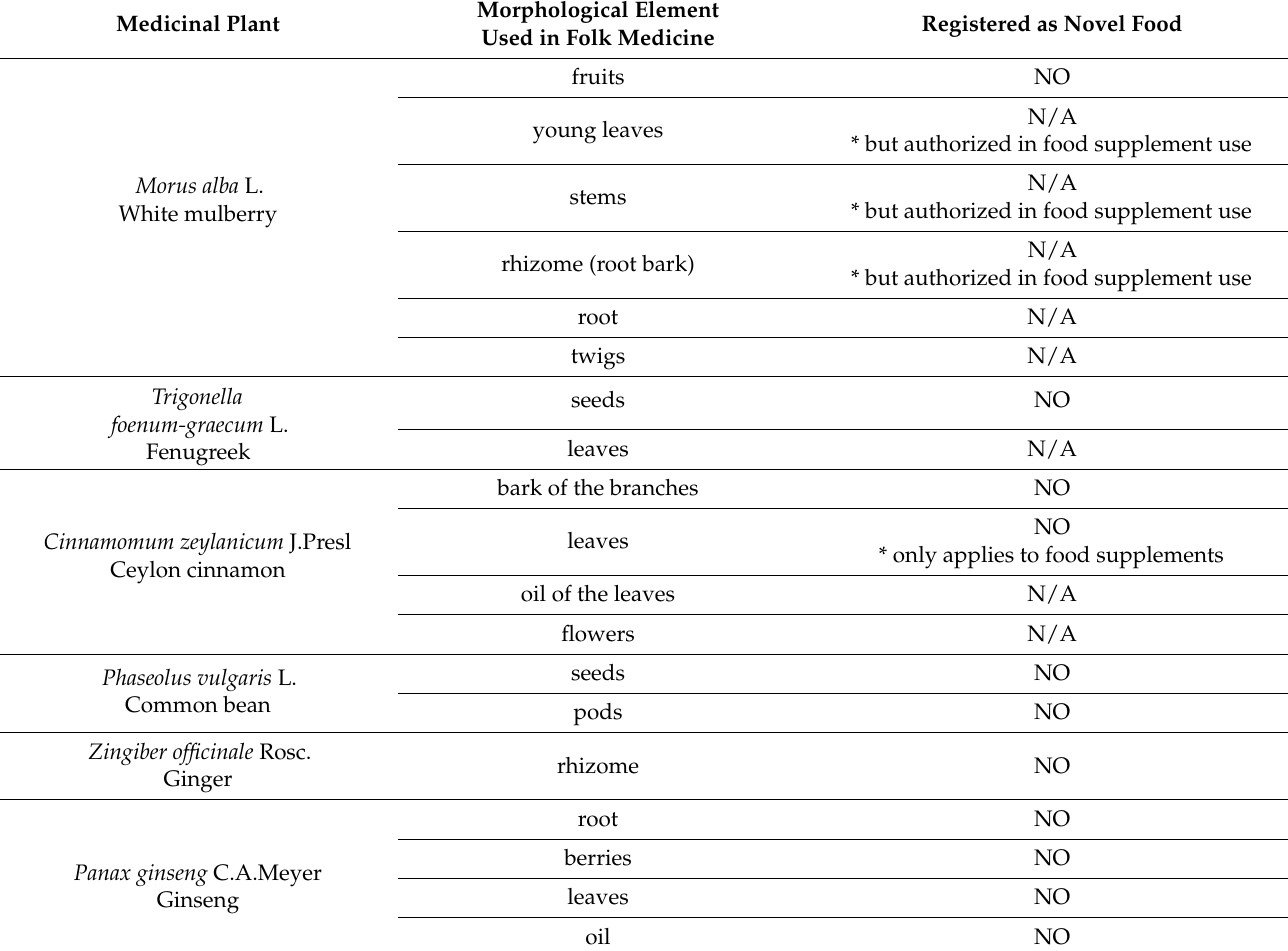
Table 2. Medicinal plants status according to EFSA legislation